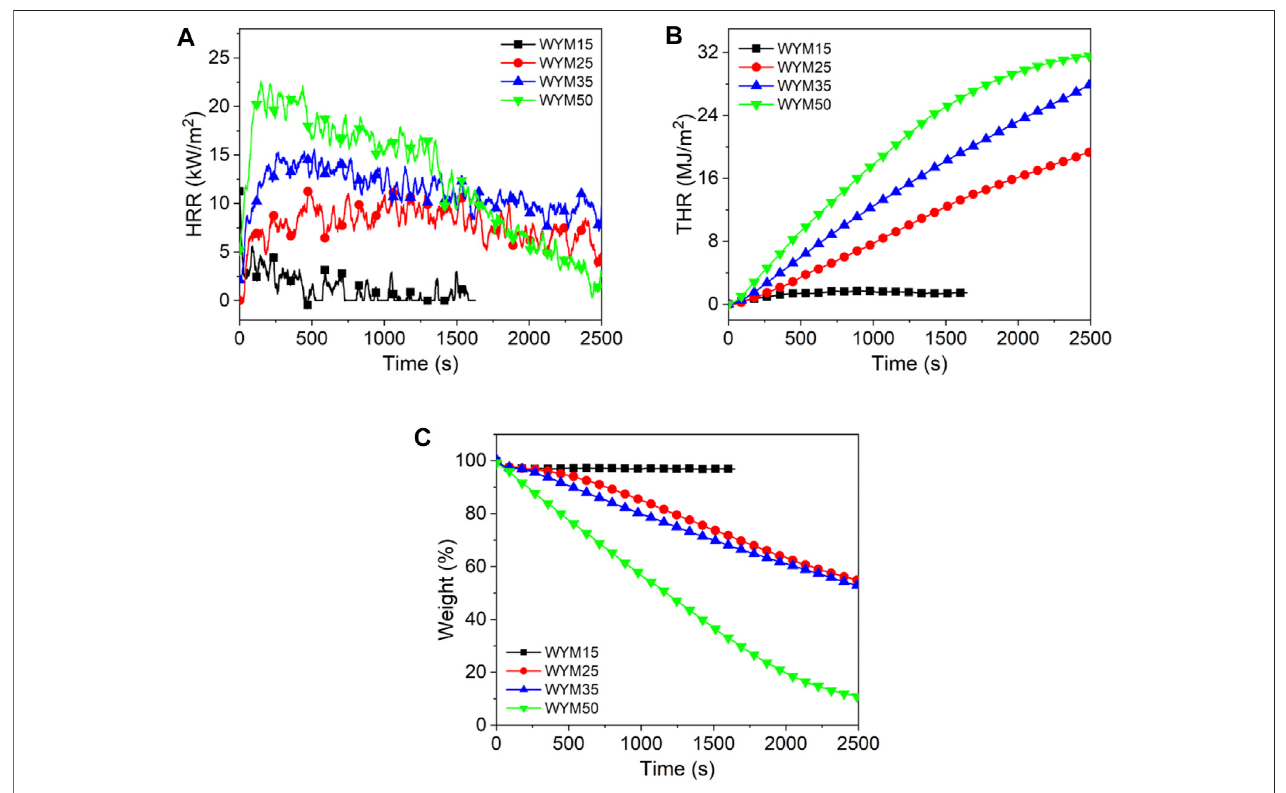
FIGURE 3 | Anthracite curves: (A) HRR, (B) THR, and (C) Char residue.